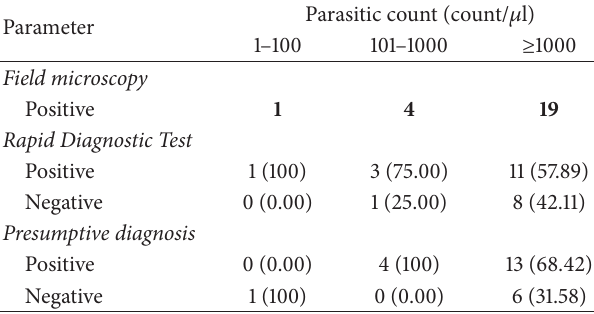
Table 4: Dose response threshold for rapid and presumptive diagnostic tests stratification by parasite density in thick blood